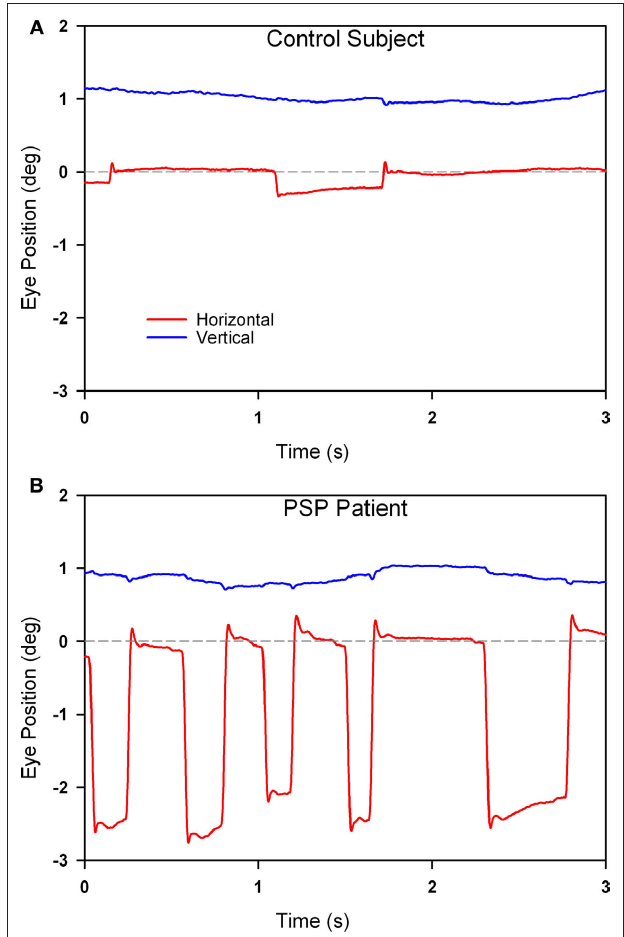
Figure 5 | Comparison of fixation behavior in a normal elderly subject (A) and in a patient with PSP (B). Both show saccadic intrusions (square- wave jerks), but they are larger and more frequent in the record from the PSP patient. The gray dashed line corresponds to the desired horizontal position of fixation. The vertical channel has been offset in both records to aid clarity. Positive values indicate rightward and upward